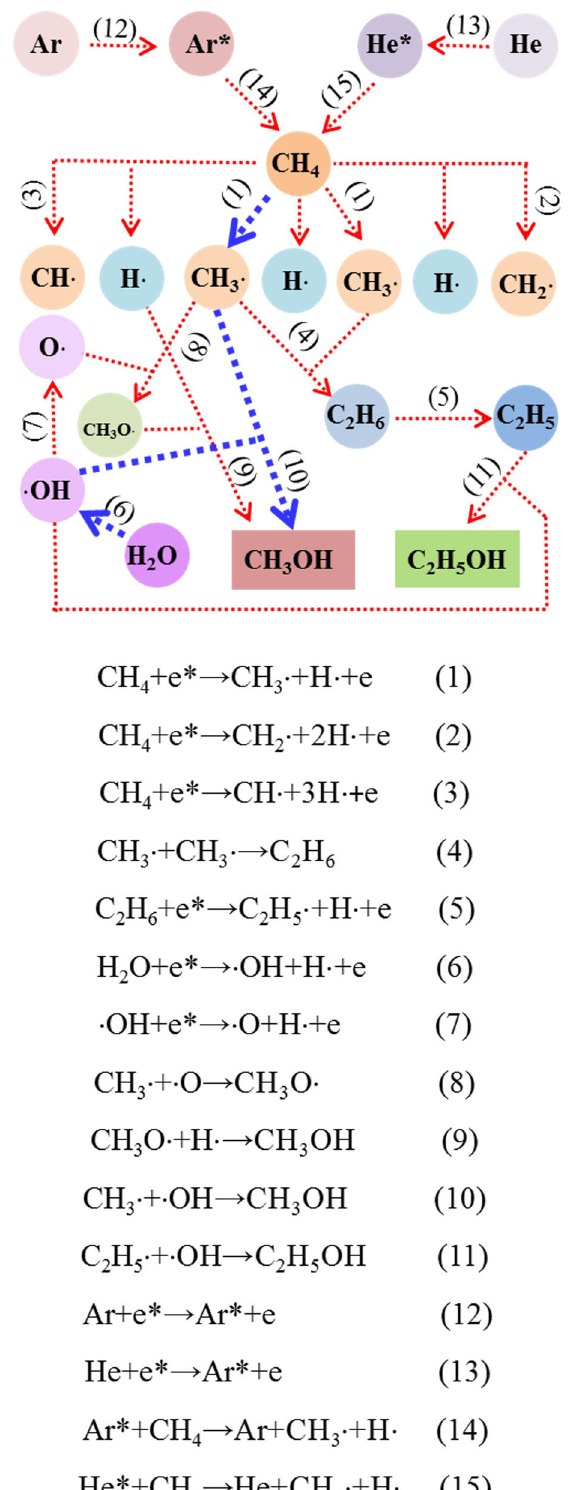
Fig. 4 Possible reaction pathways for the reaction between CH 4 and H 2 O with DBD. The methanol produced by the reaction mainly originates from the combination of methyl radicals (CH 3 ·) and hydroxyl radicals (·OH).